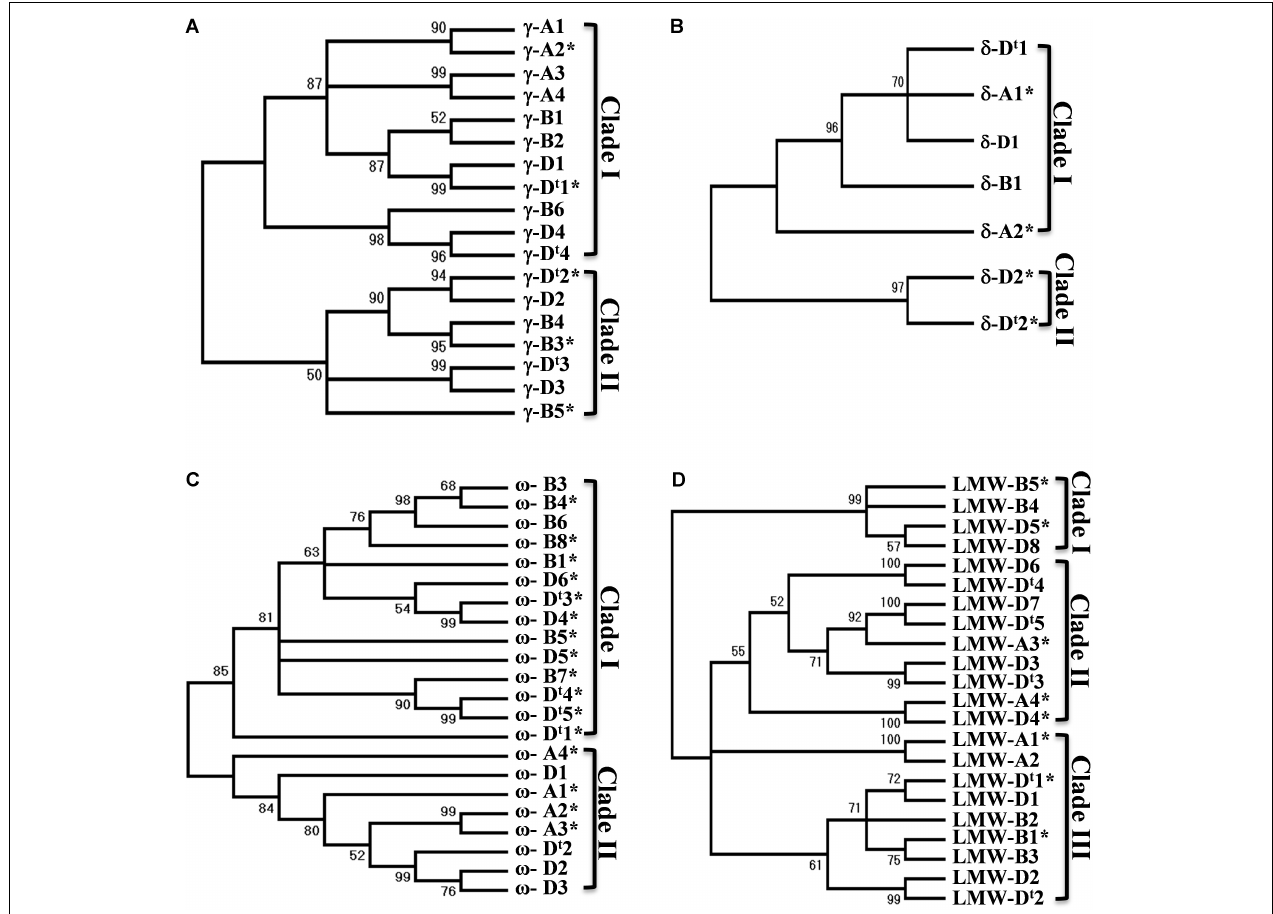
FIGURE 3 | Phylogenetic trees for prolamin genes. Nucleotide sequences of different groups of prolamin genes from the A, B, and D genomes of Chinese Spring and D genome of Ae. tauschii were used for phylogenetic analysis. Phylogenetic trees ( A for γ -gliadin, B for δ -gliadin, C for ω -gliadin, and D for LMW-GS) were reconstructed using MEGA7 with the Neighbor-Joining method. The bootstrap consensus tree inferred from 1000 replicates is taken to represent the evolutionary history of the prolamin genes analyzed. The percentage of replicate trees in which the associated genes clustered together in the bootstrap test (1000 replicates) are shown next to the branches. Sequences from Ae. tauschii are indicated with t